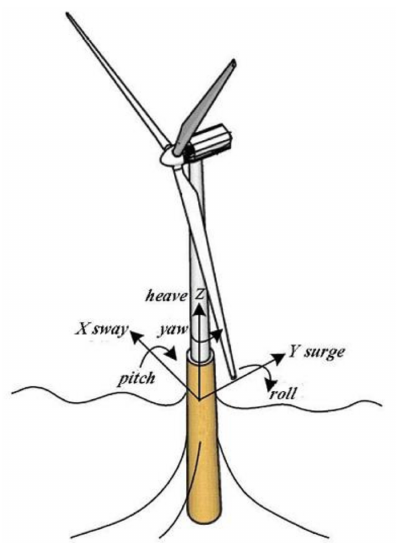
Figure 3. The degrees of freedom of an offshore floating wind turbine platform